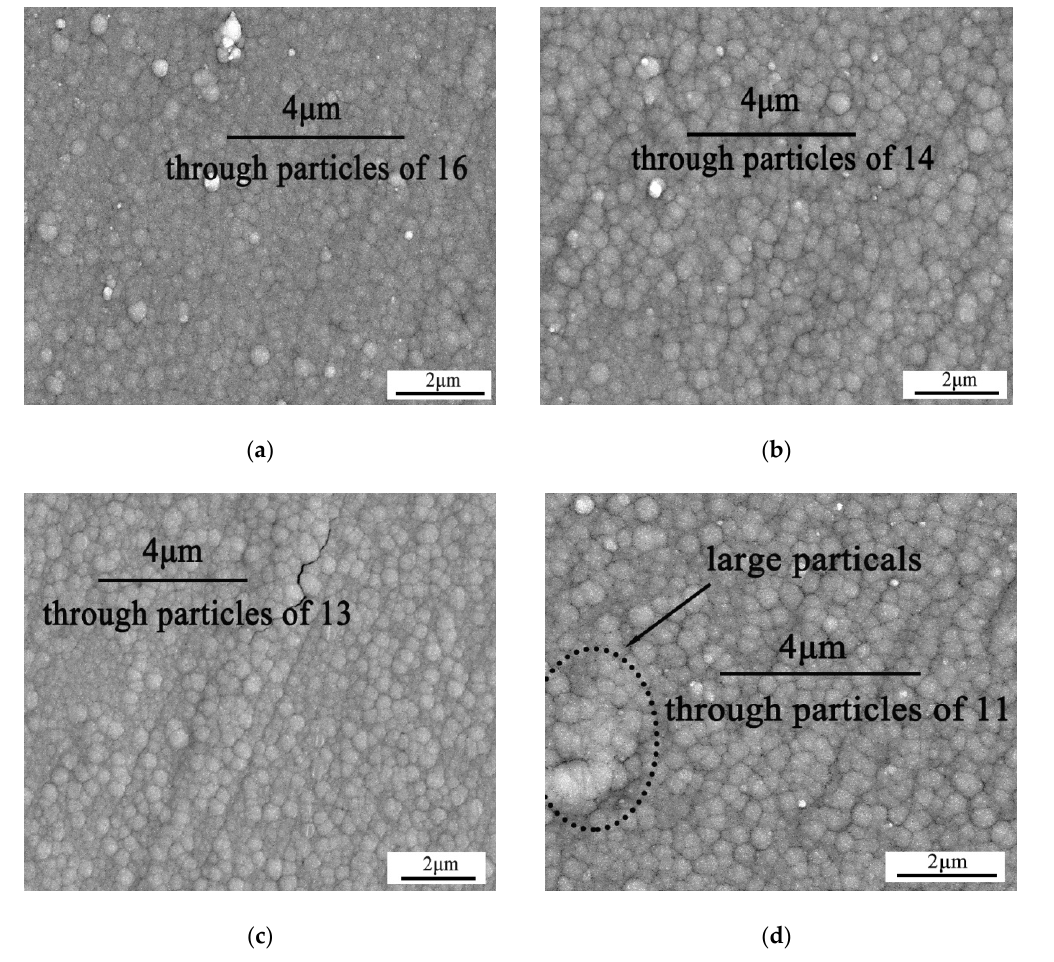
Figure 3. The BSE micrographs of the as-electroplated Co-Mo barrier layers with current of: ( a ) 0.09 A, ( b ) 0.11 A, ( c ) 0.13 A and ( d ) 0.15 A. The grain size of the electroplated layer increases gradually with the increasing current.